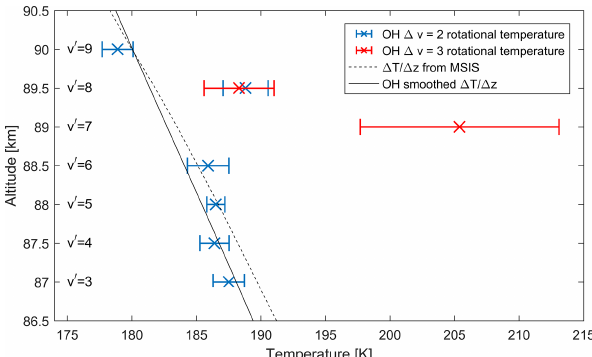
Figure 5. The temperatures from the data presented in Fig. 4 with (cid:49)v = 2 in blue and (cid:49)v = 3 in red. Both are presented with their 1 σ error bar. The altitude of the (9, 7) transition was fixed with a steady- state model using a neutral atmosphere. The altitudes of the other transitions are fixed with a relative distance between neighbour- ing transitions of 0.5km, following von Savigny et al. (2012). The NRLMSISE temperature gradient for 19 February 2013 at La Palma (17 ◦ 53 (cid:48) W, 28 ◦ 45 (cid:48) N) at 05:50UT is shown as a dashed black line. The same gradient but smoothed with a modelled OH distribution in altitude is shown as a solid black